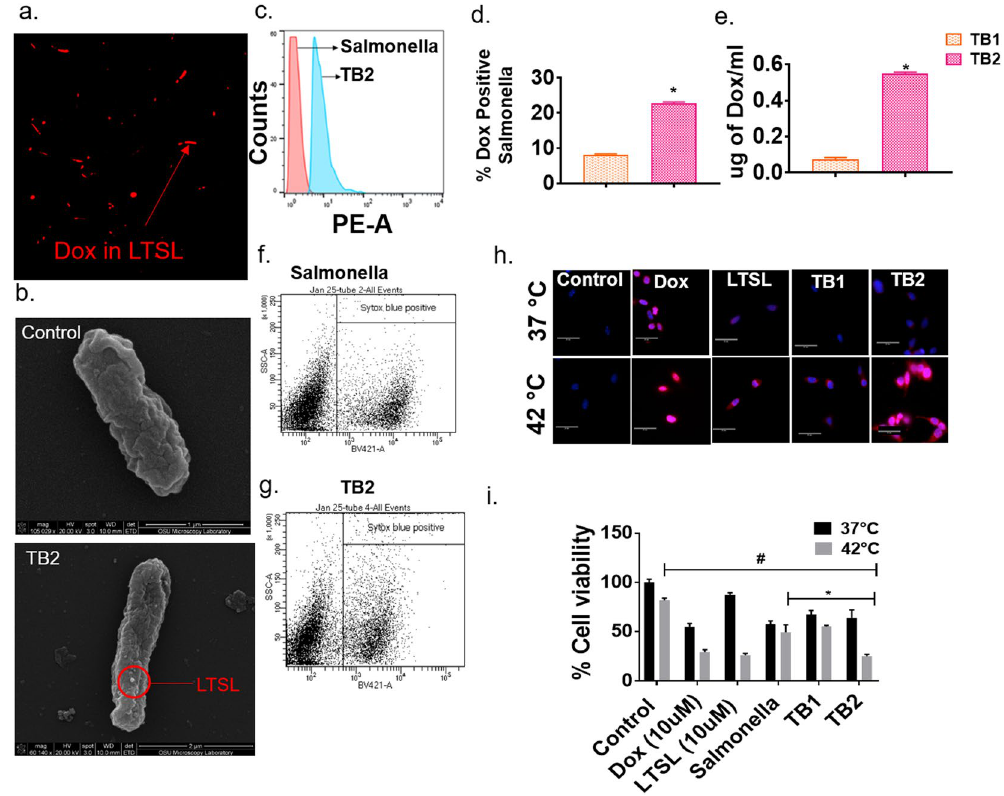
Figure 2. In vitro characterization of thermobots. ( a ) Epifluorescence microscopy showed LTSL presence on the Salmonella membrane as indicated by red fluorescence of Dox. Salmonella alone (not shown) was used as control and didn’t demonstrate any fluorescence. All images were captured with the 60x oil immersion objective lens; ( b ) SEM image of Salmonella showed punctate liposomal dots on the membrane; ( c ) Histogram plots indicated a gradual increase in the MFI for bacterial population positive for dox (depicted in blue) compared to the control (depicted as red peak); ( d , e ) Dox quantification by spectroscopy and flow cytometry demonstrated 2–4 fold greater drug loading with streptavidin-biotin crosslinking for TB2 compared to TB1 (p < 0.0001); ( f , g ) Viability of TB showed no major shift in the dead cell population compared to controls in the FACS density plot with SYTOX staining; ( h ) Streptavidin-biotin cross linking improved intracellular dox delivery for TB2 compared to passively loaded TB1.Confocal images were captured at 40x magnification. Dox is shown in red and nuclei in blue; ( i ) Cellular viability of C26 colon cells post treatment with dox, LTSL and TBs enhanced bacterial killing at 42 °C compared to 37 °C; Values represent mean ± SE, and were normalized to control samples at 37 °C. (n = 6; ANOVA followed with tukeys).